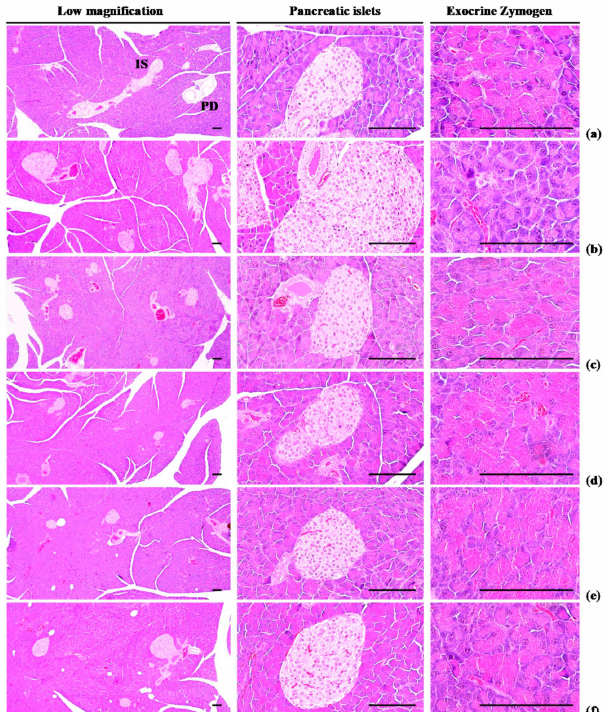
Figure 5. Representative general histological images of the pancreas, taken from NFD or HFD